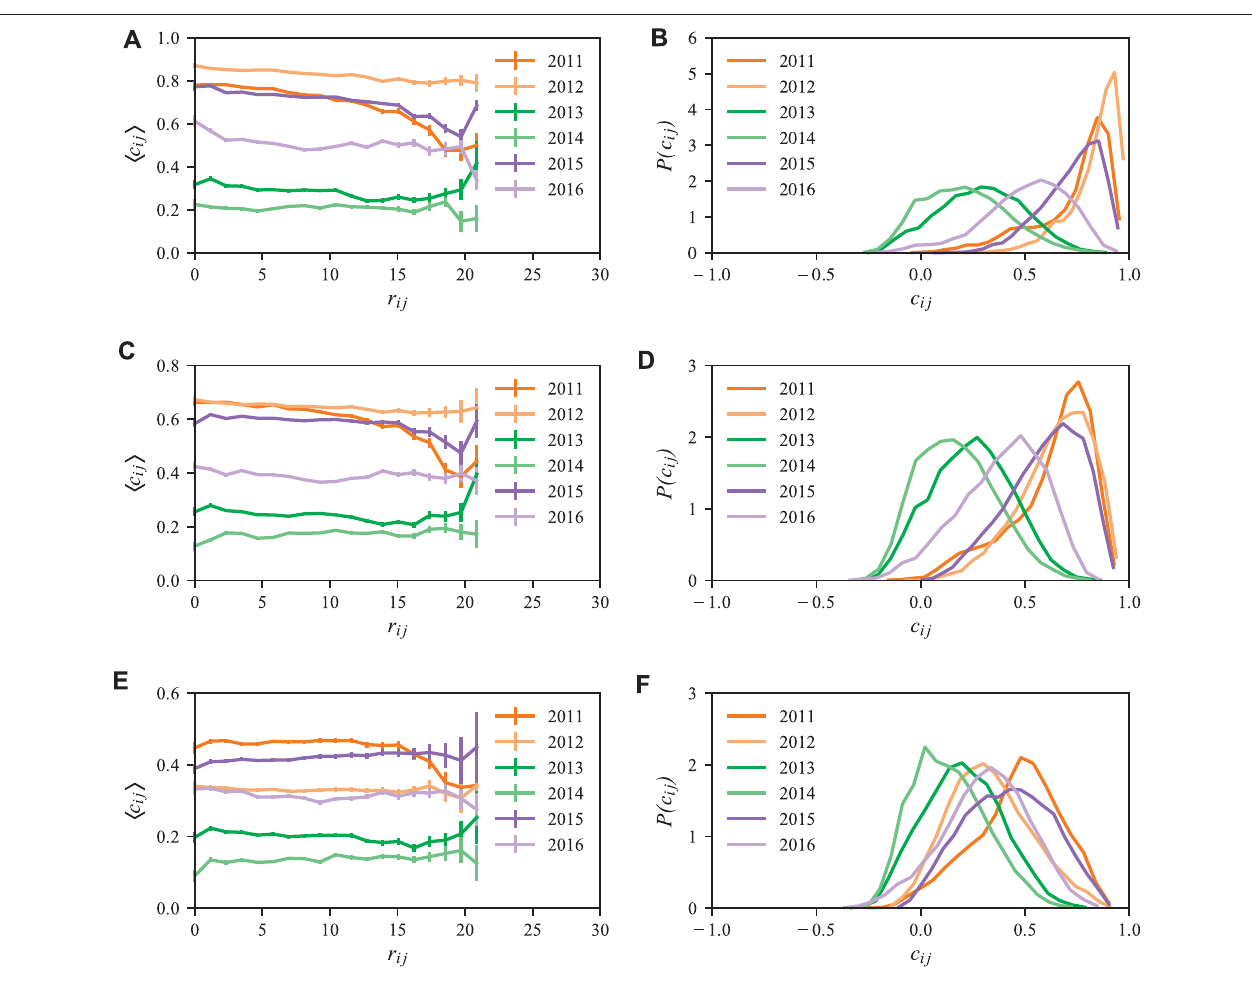
FIGURE 5 | Correlations for different time lags, distances and years and their corresponding distributions. The left panels show the average of the spatio-temporal correlations 〈 c ij ( τ ) 〉 asafunctionofthedistance r ij betweenneighborhoods i and j ,andcalculatedfortimelagsof τ 0 =0weeks (A,B) , τ 1 =2weeks (C,D) ,and τ 2 =4weeks (E,F) . As depicted, epidemic years (2011, 2012, 2015, and 2016) present a higher 〈 c ij ( τ ) 〉 when compared to non-epidemic years (2013 and 2014). The right panels showthecorrespondingdistribution P ( c ij ) of c ij ( τ ).Epidemicyearspresentanegativeskewnessof P ( c ij ),whilenon-epidemicyearshavenoskewness.Thebarsare the standard